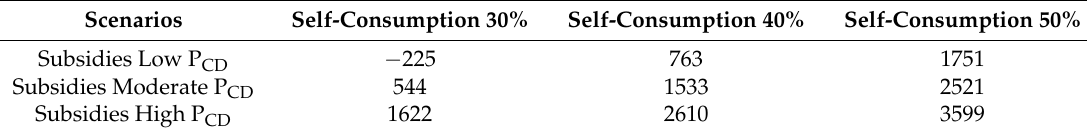
eq/kWh ). Data expressed in € 2